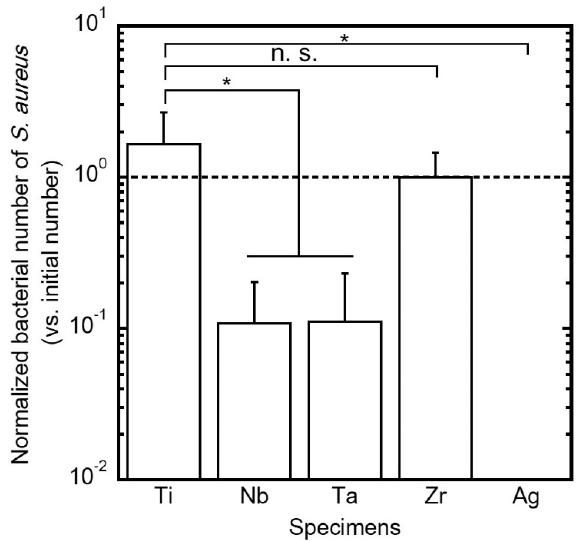
Figure 5. The number of S. aureus attached to each specimen 24 h after seeding. Data are shown as the mean ± SD. *: Significant di ff erence against Ti; n.s.: No significant di ff erence against Ti (ANOVA + SNK mean ± SD. *: Significant difference against Ti; n.s.: No significant difference against Ti (ANOVA + ( p < 0.05, N = SNK ( P < 0.05, N = 5)).